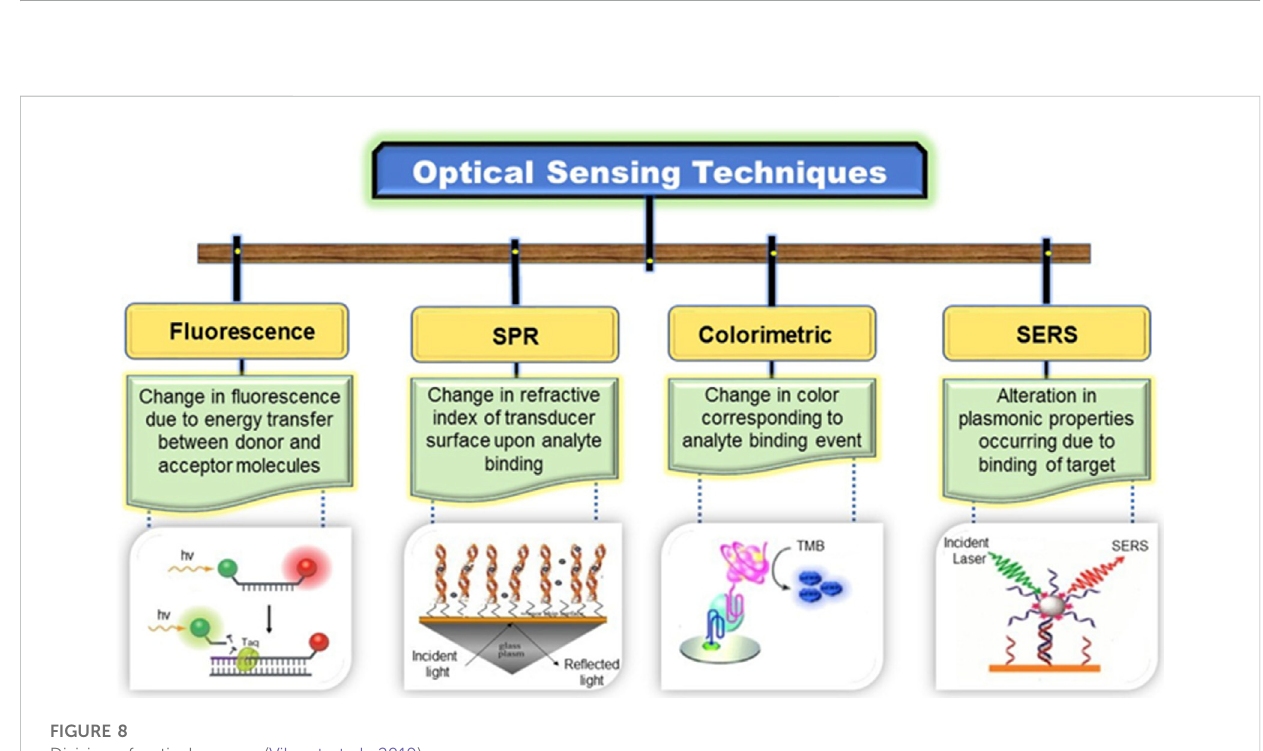
of target DNA. SERS provides an enhanced Raman signal of 10 6 – 10 14 order of magnitude owing to the electromagnetic interaction between the metal. Nanostructures and the analyte. SERS-based biosensors have a comparatively low cost, high sensitivity, rapid results, and